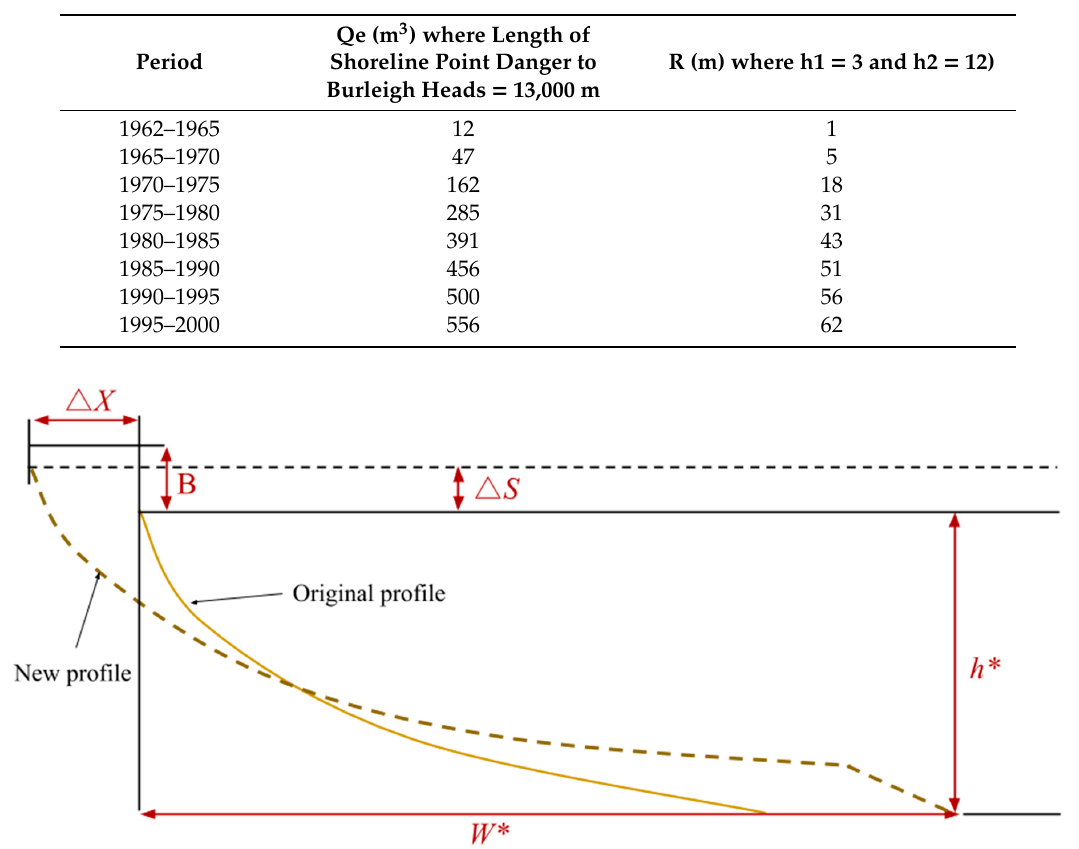
Figure 3. Beach response to sea level rise (Dean and Houston, 2016). ∆ X = shoreline change; ∆ S = sea level rise; B = beach berm height; h = depth of closure; and W = distance from berm to depth of closure.